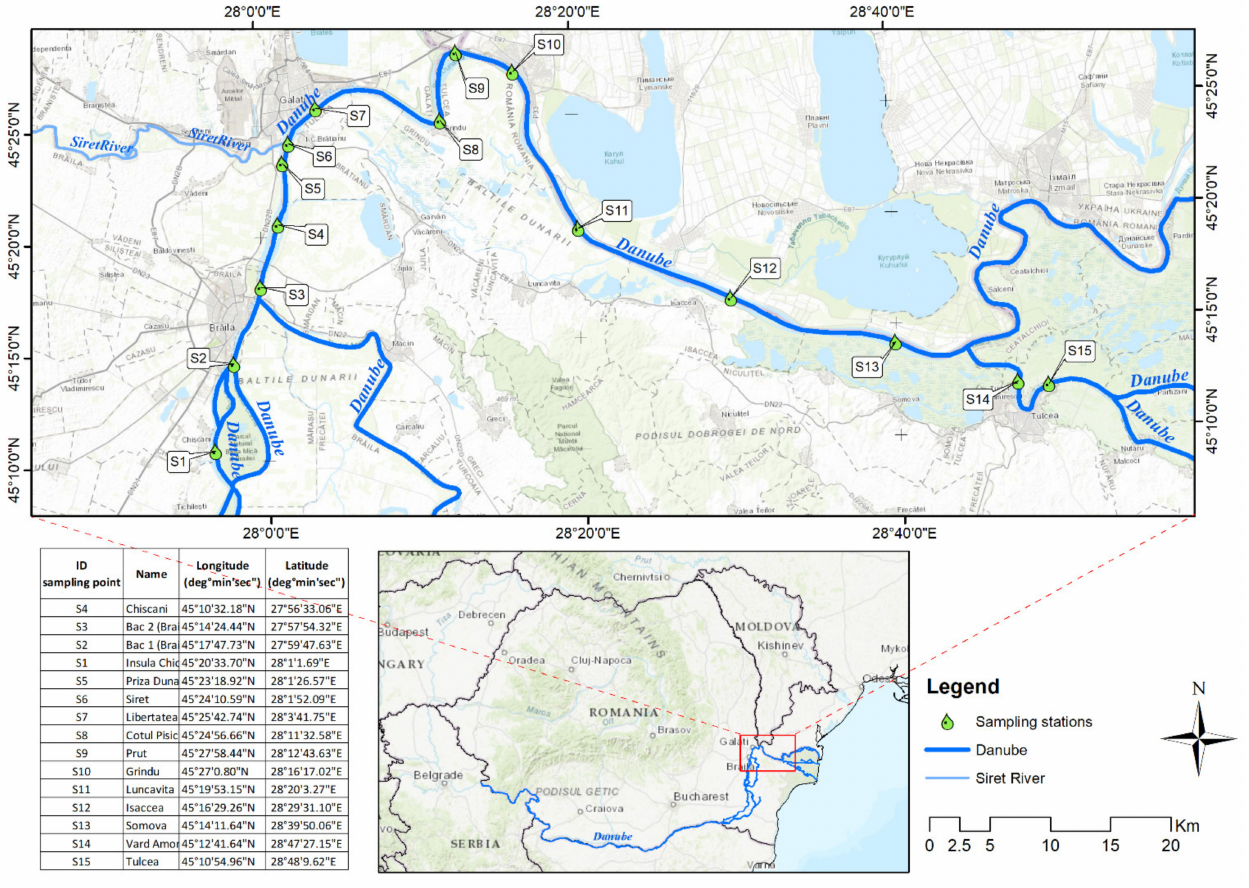
Figure 1. Sampling Stations along the lower Danube